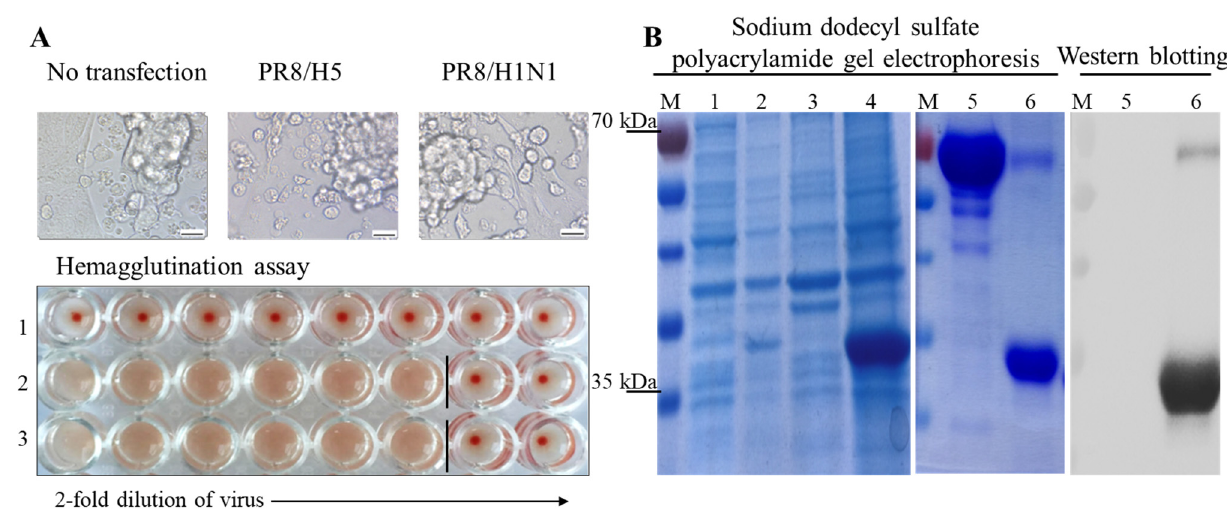
Figure 1. Preparation of recombinant virus and immunogenic protein. ( A ) Expression of recombi- nant influenza H5 hemagglutinin (HA) 2.3.4.4b virus based on the H1N1/PR8 virus backbone 3 days post-transfection. The left panel shows plasmids in the 293T and Madin–Darby canine kidney cells (MDCK) cells mixture (scale bar, 20 μ m; original magnification, 400×), and the results of the hemag- glutination assay performed for checking the titer of the recombinant virus without transfection (1), in PR8/H5 HA 2.3.4.4b (2), and in PR8/H1N1 (3). The virus titer was 1280 HAU/mL for both PR8/H1N1 and PR8/H5 2.3.4.4b (HA). ( B ) The right panel shows expression of the globular head domain H5N6 (HA) 2.3.4.4b protein in E. coli . Sodium dodecyl sulfate–polyacrylamide gel electrophoresis (SDS-PAGE) and Western blotting results are shown, M: maker; 1: non-induced lysis; 2: induced lysis; 3: non-induced pellet; 4: induced pellet; 5: BSA; and 6: final product after purification of the globular head domain protein (20 μ g/lane).